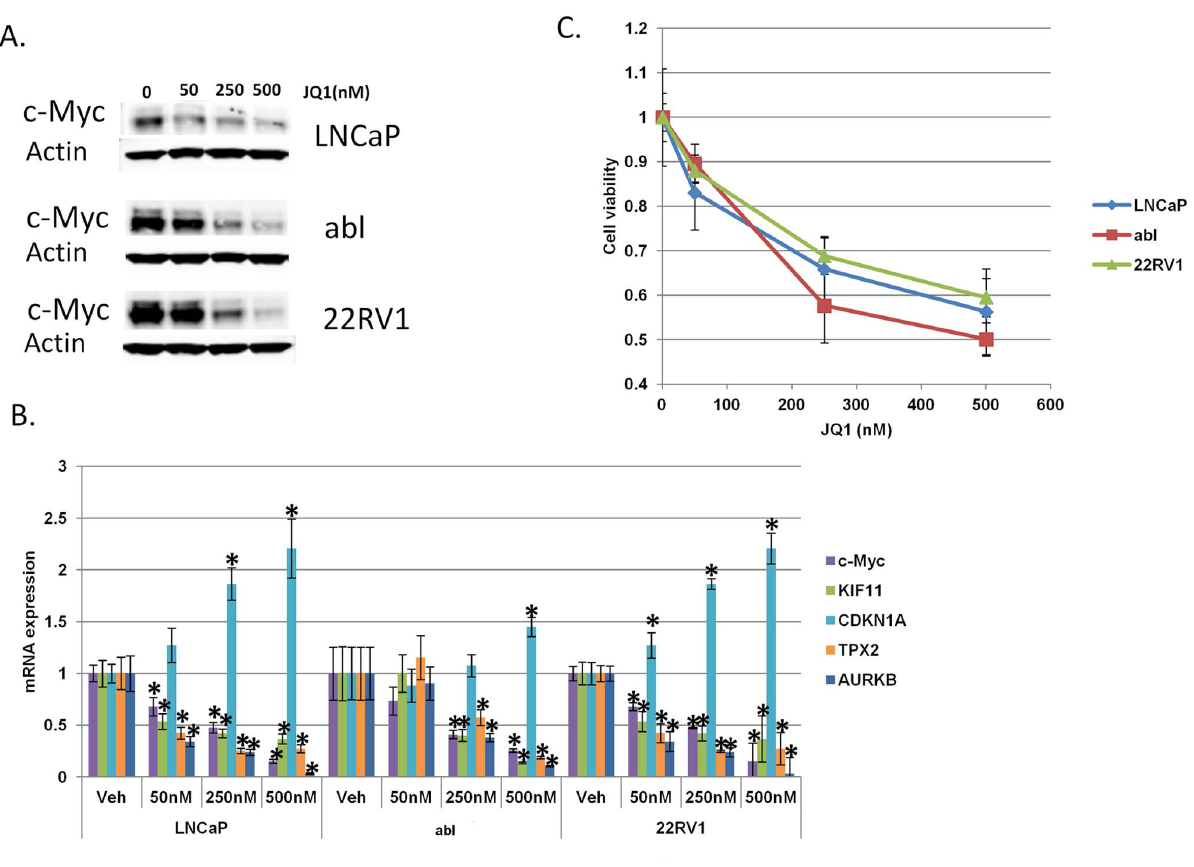
Figure 6. JQ1 treatment suppresses c-Myc expression and function and reduces ligand-independent prostate cancer cell survival. LNCaP, abl, and 22RV1 cells were grown in charcoal-stripped serum and treated with vehicle, 50 nM, 250 nM or 500 nM JQ1 every 24 hours for 72 hours. A) Immunoblotting was performed to determine the protein levels of c-Myc. B) QRT-PCR was performed to determine the mRNA level of c-Myc and c-Myc targets genes KIF11, CDKN1A, TPX2 , and AURKB relative to actin . *denotes p , 0.05 compared to vehicle. C) Cell viability was determined at the end of treatment with the trypan blue exclusion method. p , 0.01 for the 250 nM and 500 nM doses vs. vehicle in all three cell lines.